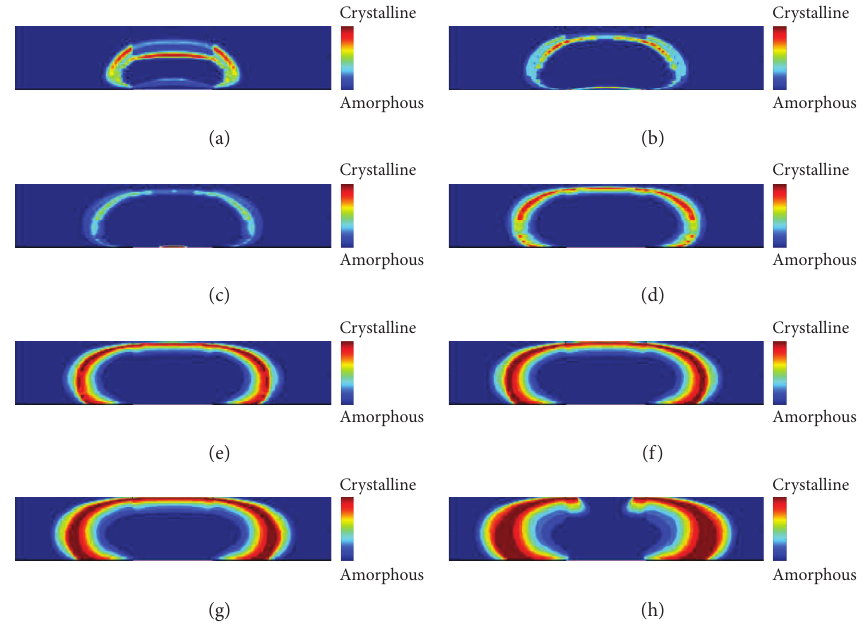
Figure 9: Phase distribution of simulation 2. The phase distribution of GSTafter imposing pulses with widths of (a) 10ns, (b) 20ns, (c) 30ns,